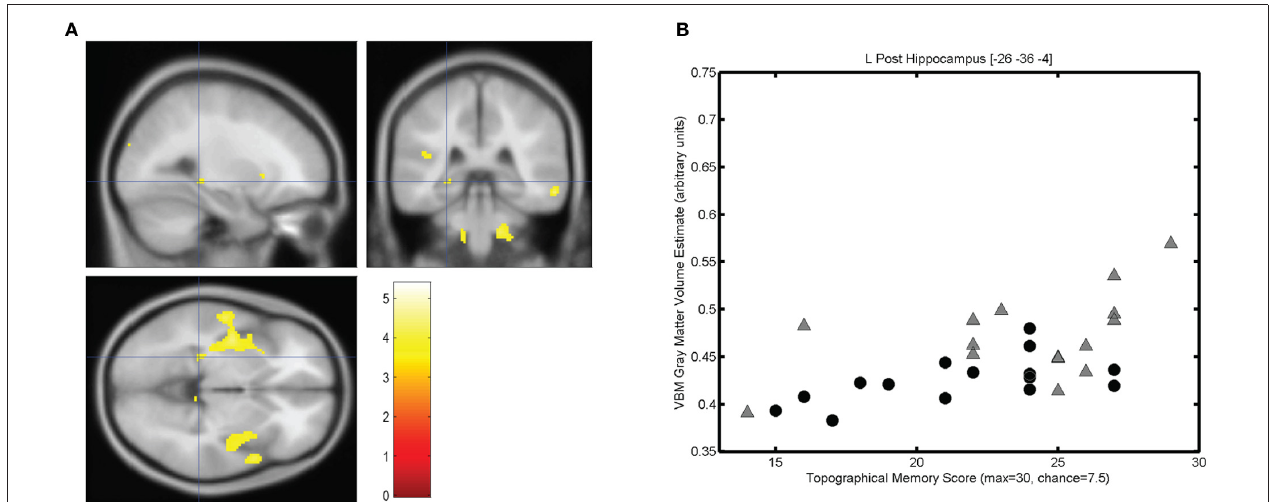
FIGURE 3 | Correlation between individuals’ hippocampal gray matter volume and topographical memory scores. (A) Regions showing a significant correlation between VBM gray matter volume estimate and score on the 30 item Four Mountains Task. Sagittal, coronal, and axial slices are centered on the peak voxel in the left hippocampus ( − 26, − 36, − 4), which is